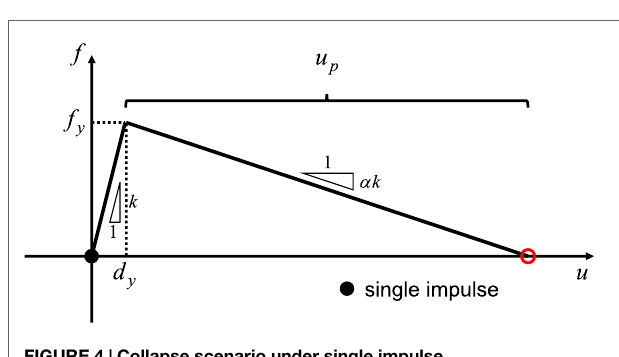
FIGURE 4 | Collapse scenario under single impulse